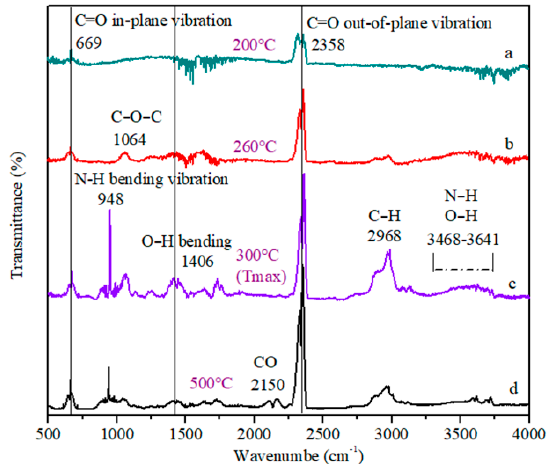
Figure 8. Thermal decomposition gas phase infrared spectrum of HPN-EPPA-UR-PA resin (For- mula D) at different temperatures, a: 200 °C; b: 260 °C; c: 300 °C ( 𝑇 (cid:3040)(cid:3028)(cid:3051) ); d: 500 °C. mula D) at different temperatures, a: 200 ◦ C; b: 260 ◦ C; c: 300 ◦ C ( T max ) ; d: 500 ◦ C. Table 2. Decomposition temperature and carbon residue of HPN-EPPA-UR-PA resin.